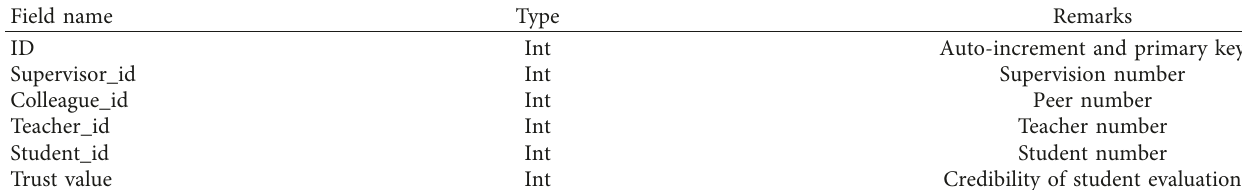
Table 10: Weight setting of teaching